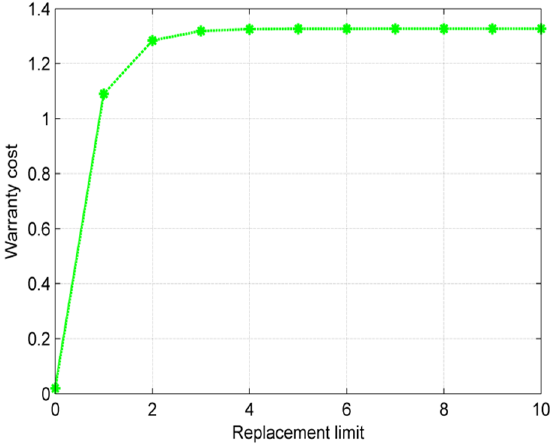
Figure 1. Warranty cost versus n .